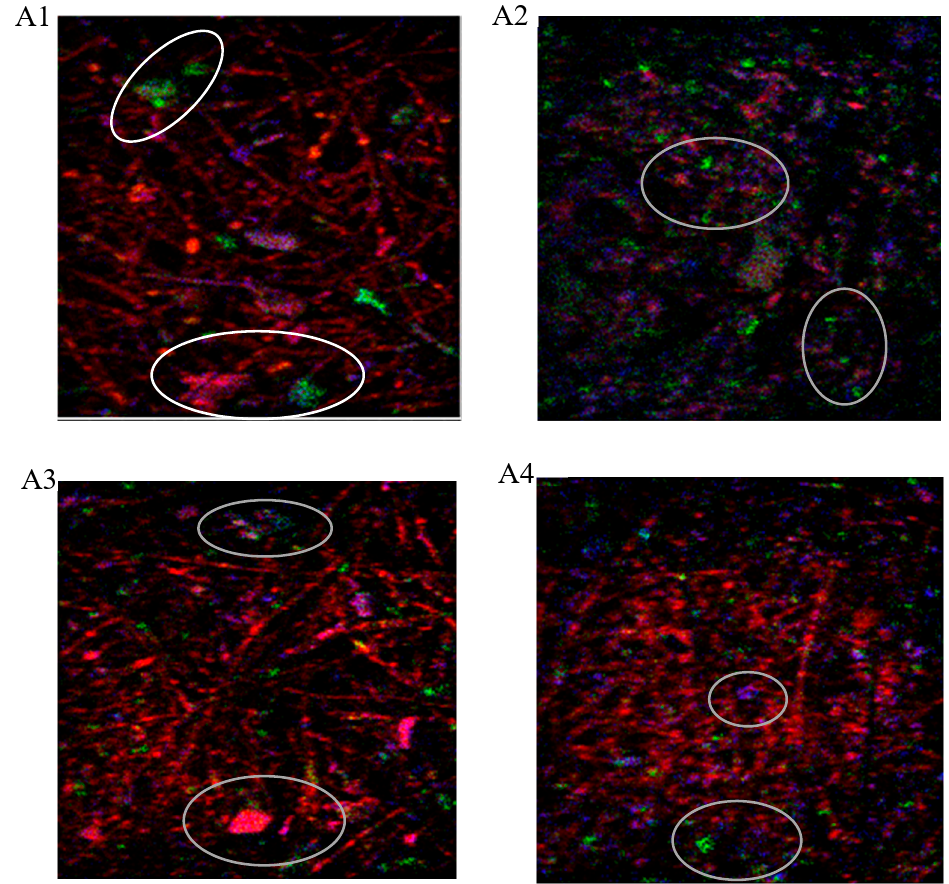
Figure 4. Images of PM 2.5 under positive mode. ( A1 , A2 ) were low-concentration samples (35.6 and 41.7 µ g × m − 3 ), ( A3 , A4 ) were high-concentration samples (132.6 and 98.4 µ g × m − 3 ); relative humidity (RH) on sampling day was 32%, 38%, 35%, and 32%, respectively. Green, fuchsia, and blue represent Ca + , K + , and Mg + , respectively.